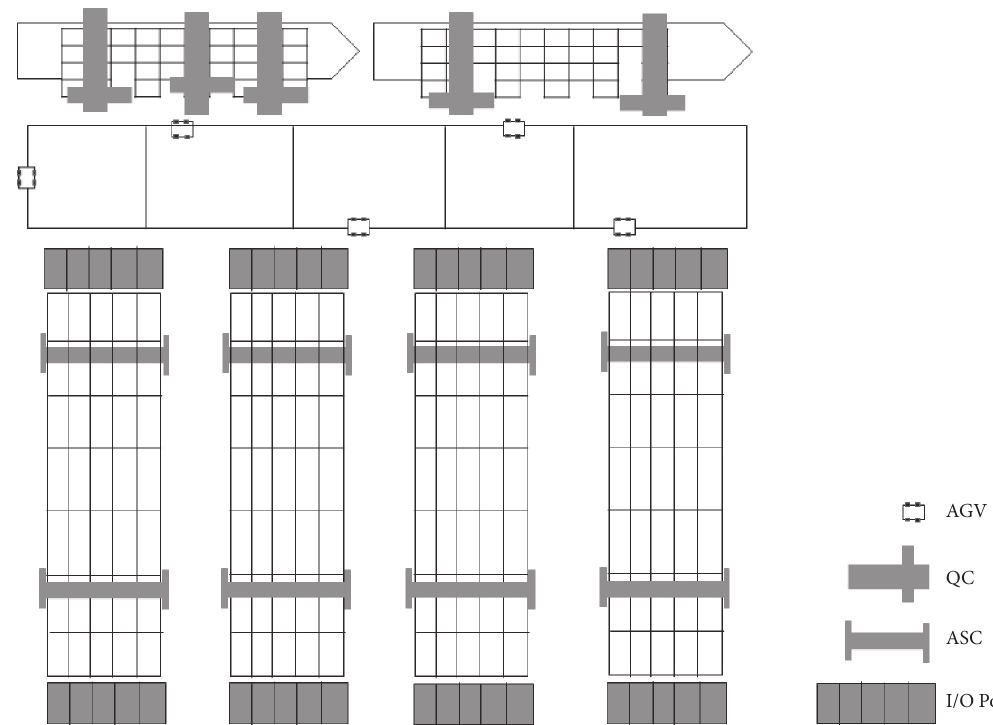
Figure 1: Automated container terminal layout.